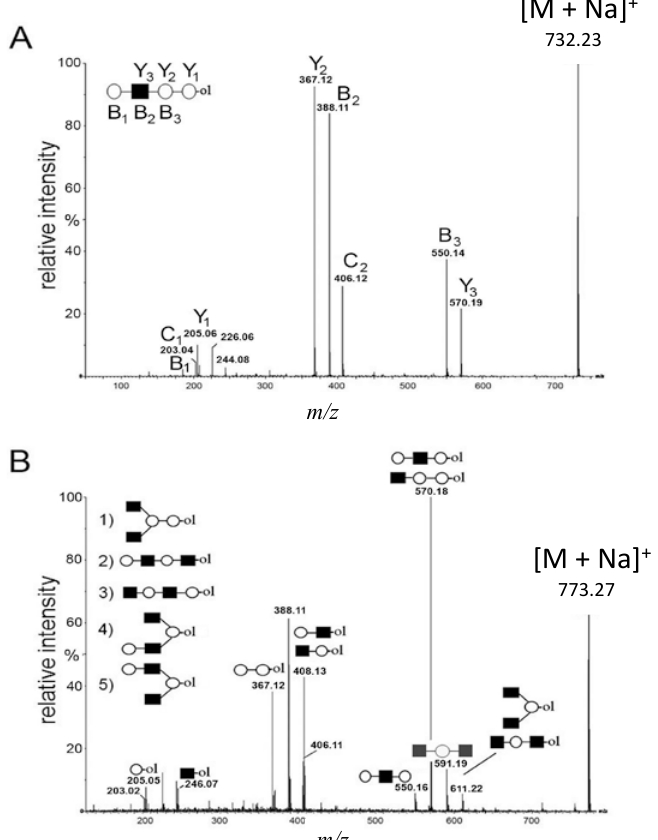
Figure 2. The (+) MALDI Q-TOF collision-induced dissociation (CID) spectra of two low mass oligosaccharide alditol ions from the mixture (Figure 1). ( A ) Tetrasaccharide alditol lacto- N -tetraose (732.23); and ( B ) isobaric mixture of tetrasaccharide alditols (773.27) of the sum composition Hex HexNAc 2 2